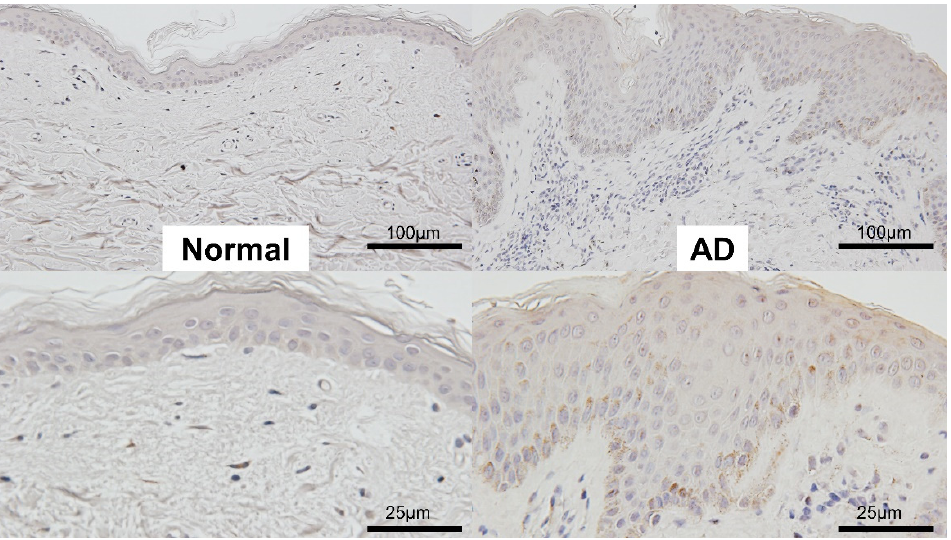
Figure 4. Immunohistochemistry of TL1A in atopic dermatitis (AD) or normal skin samples. Immunohistochemistry was performed with anti-human TL1A antibody (ab234307, Abcam, UK). Representative photos were shown. Left two panels show normal skin, and right two panels show AD. Low magnification in upper panels, and high magnification in lower panels.